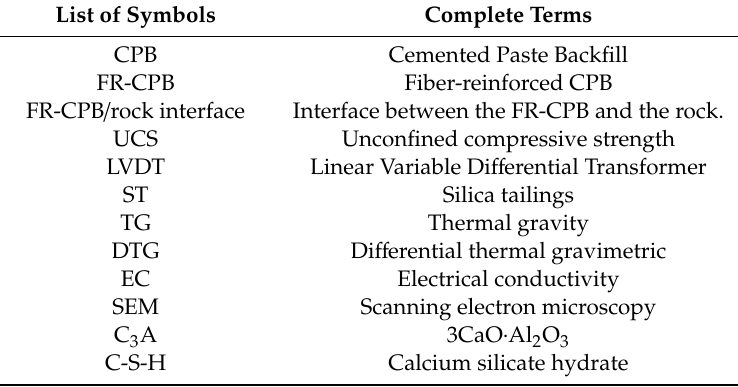
Table 1. Nomenclature